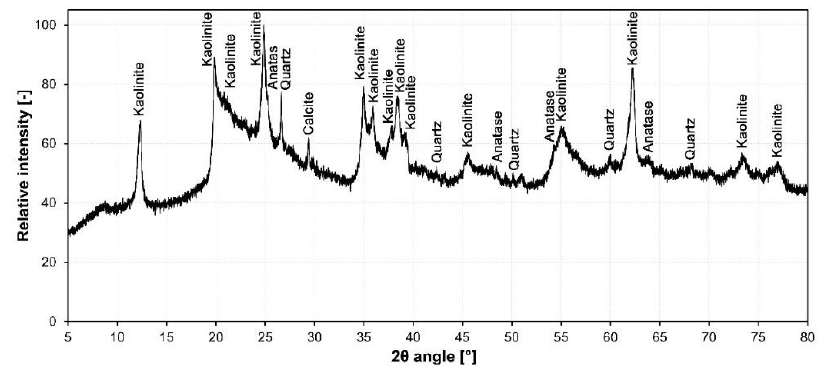
Figure 2. XRD pattern of waste diatomaceous earth.